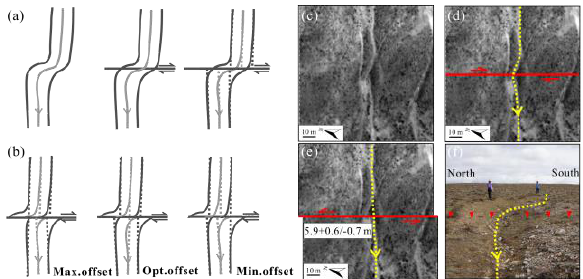
Figure 3. Measurement of strike slip using the back-slipping